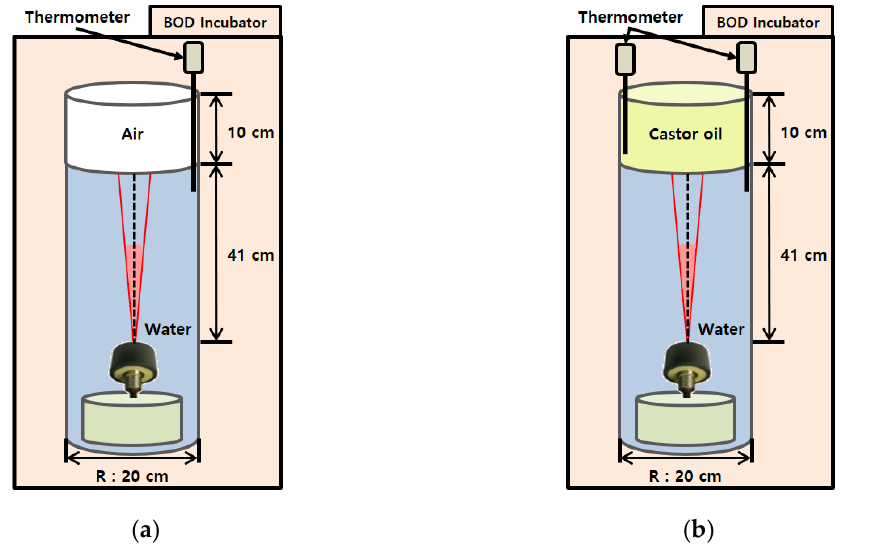
Figure 3. Acoustic measurement system for reflection loss as a function of temperature for ( a ) a water-air interface and ( b ) a water-castor oil interface. The near-field transmission-loss measurements in the water medium were first made in the case of water-air interface, and the results were applied to reflection-loss measurement for a water-castor oil interface.